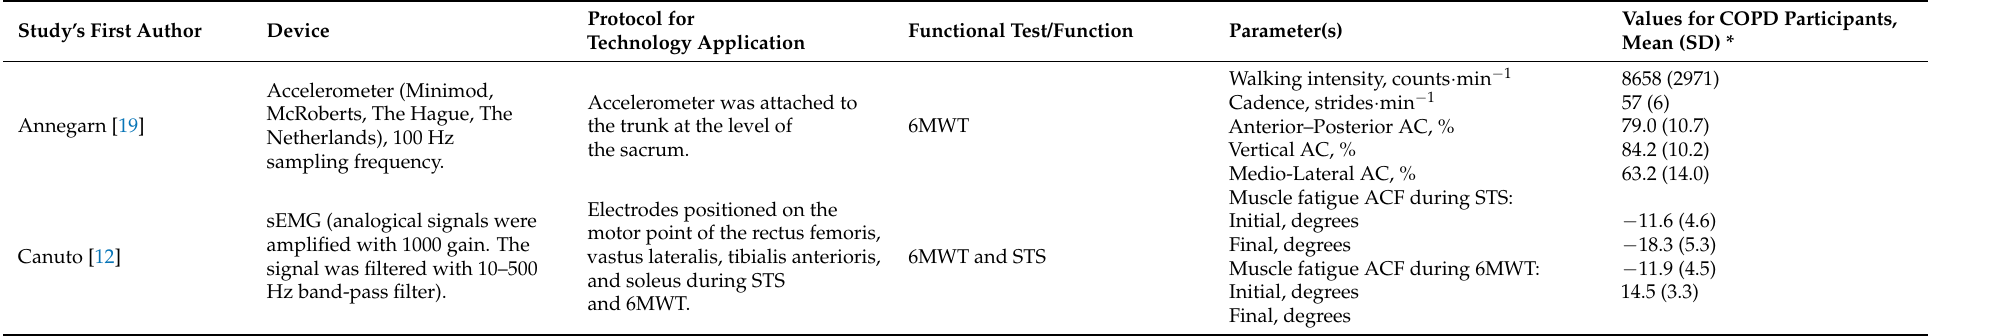
Table 2. Wearable devices employed and functions/parameters estimated in application